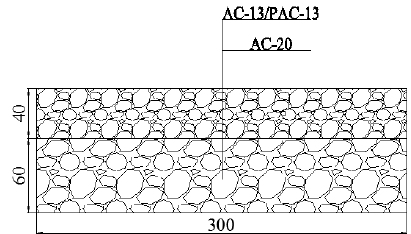
Figure 1. Schematic diagram of the